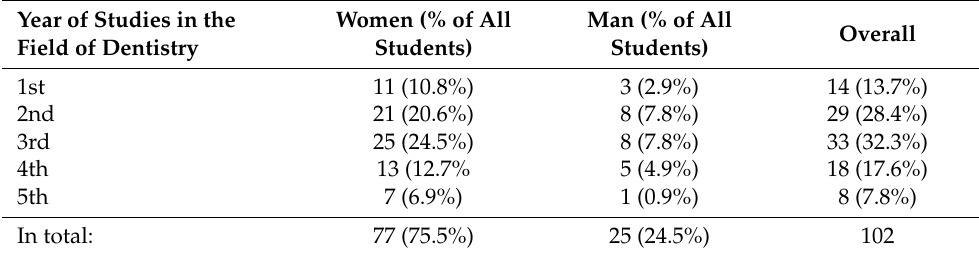
Table 2. Characteristics of a selected group of dental